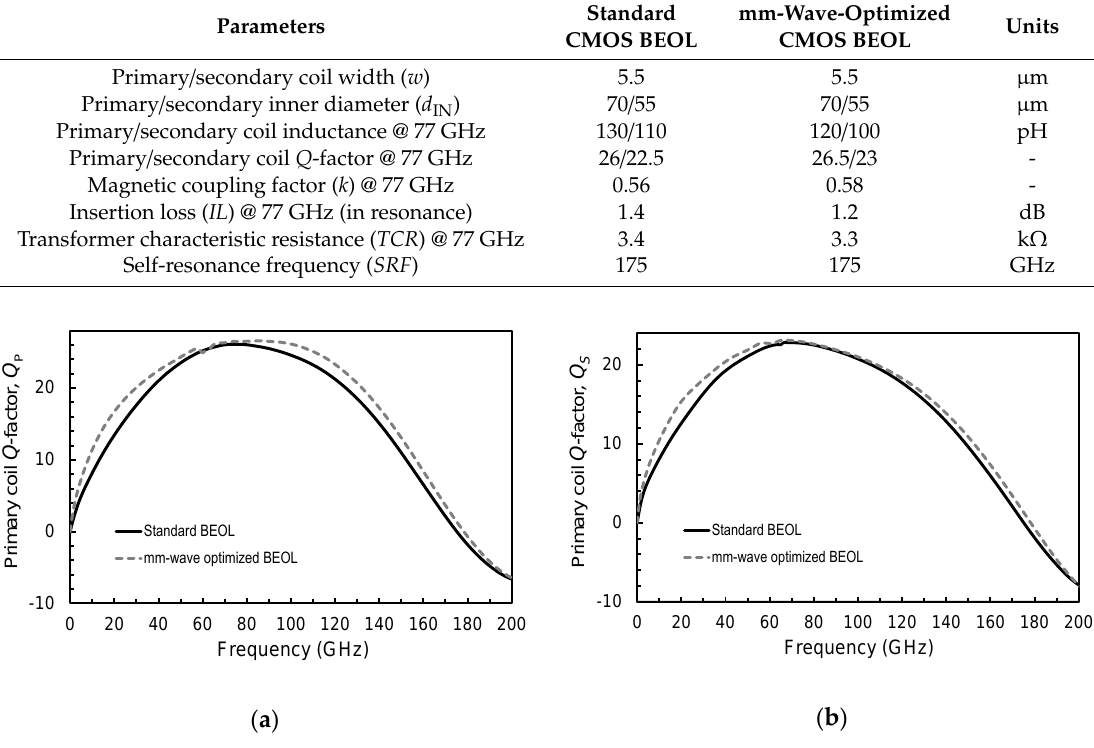
Figure 9. BEOL comparison for interleaved transformer T 2 of Table 2: ( a ) primary coil Q -factor, Q P ; ( b ) secondary coil Q -factor, Q S .